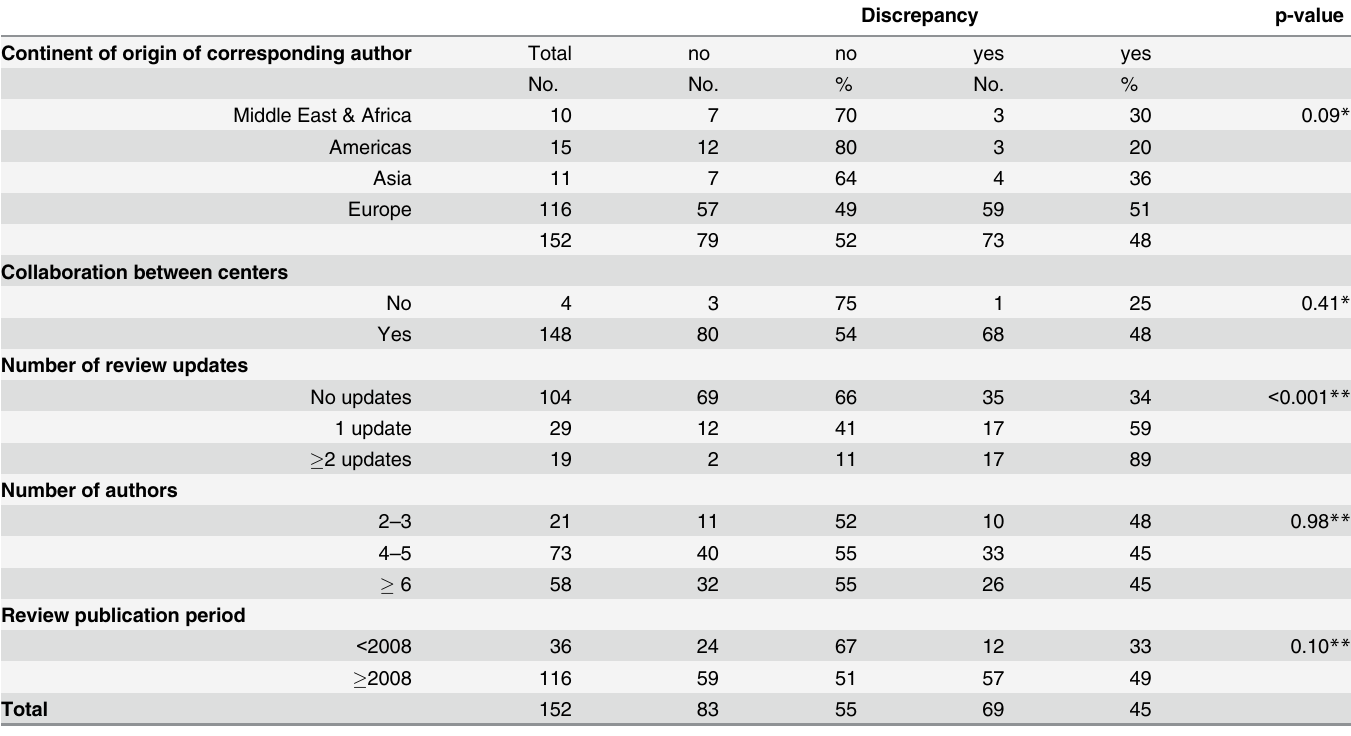
Table 1. Distribution of any discrepancies between protocols and reviews per geographical area, single or multicenter collaboration, number of review updates, number of authors and review publication period.